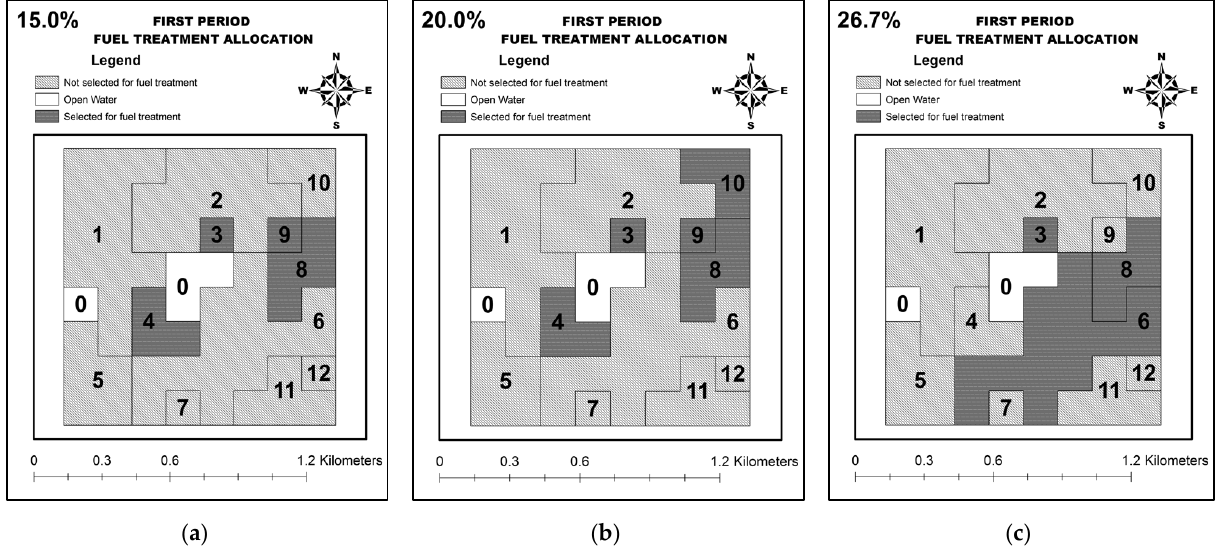
Figure 11. Some alternatives FT1s under low FPV assumption: ( a ) smaller area treated; ( b ) medium area treated; ( c ) larger area treated.